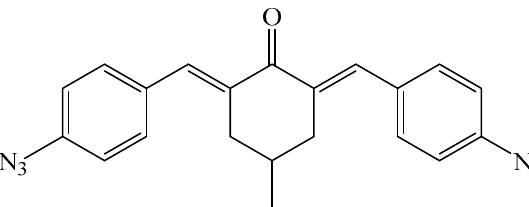
Figure 15. Chemical structure of 2,6-bis(4-azidobenzylidene)-4-methylcyclohexanone.